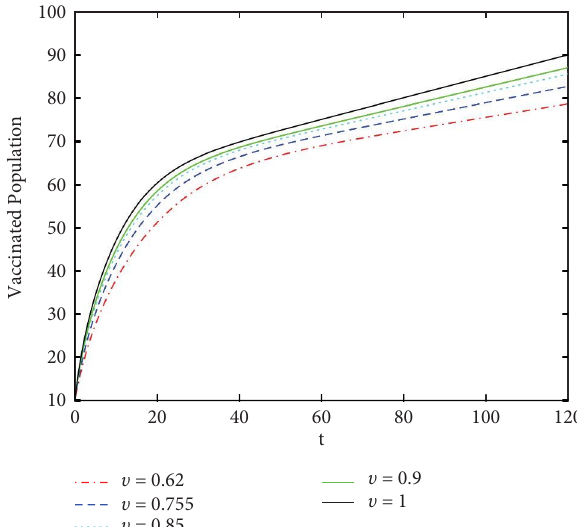
Figure 16: Te dynamics of infected human population for various fractal orders π and for fractional order υ � 0 . 5.